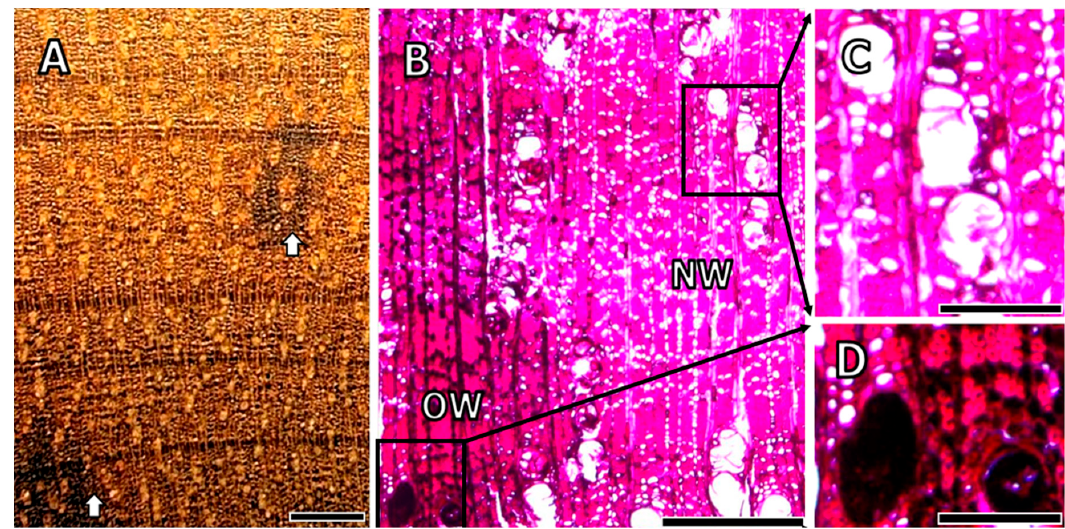
Figure 4. Anatomy of fire trace in D. butyracea wood; ( A ) fire traces (black spots) on the stem disc (white arrow indicated), stereomicroscopic image; ( B ) light micrograph showing oxidized and normal wood; ( C ) non-oxidized wood; and ( D ) fire induced oxidized wood. Scale bars = 500 µm ( A and B ) and 200 µm ( C and D ). OW, oxidized; NW, non-oxidized wood.